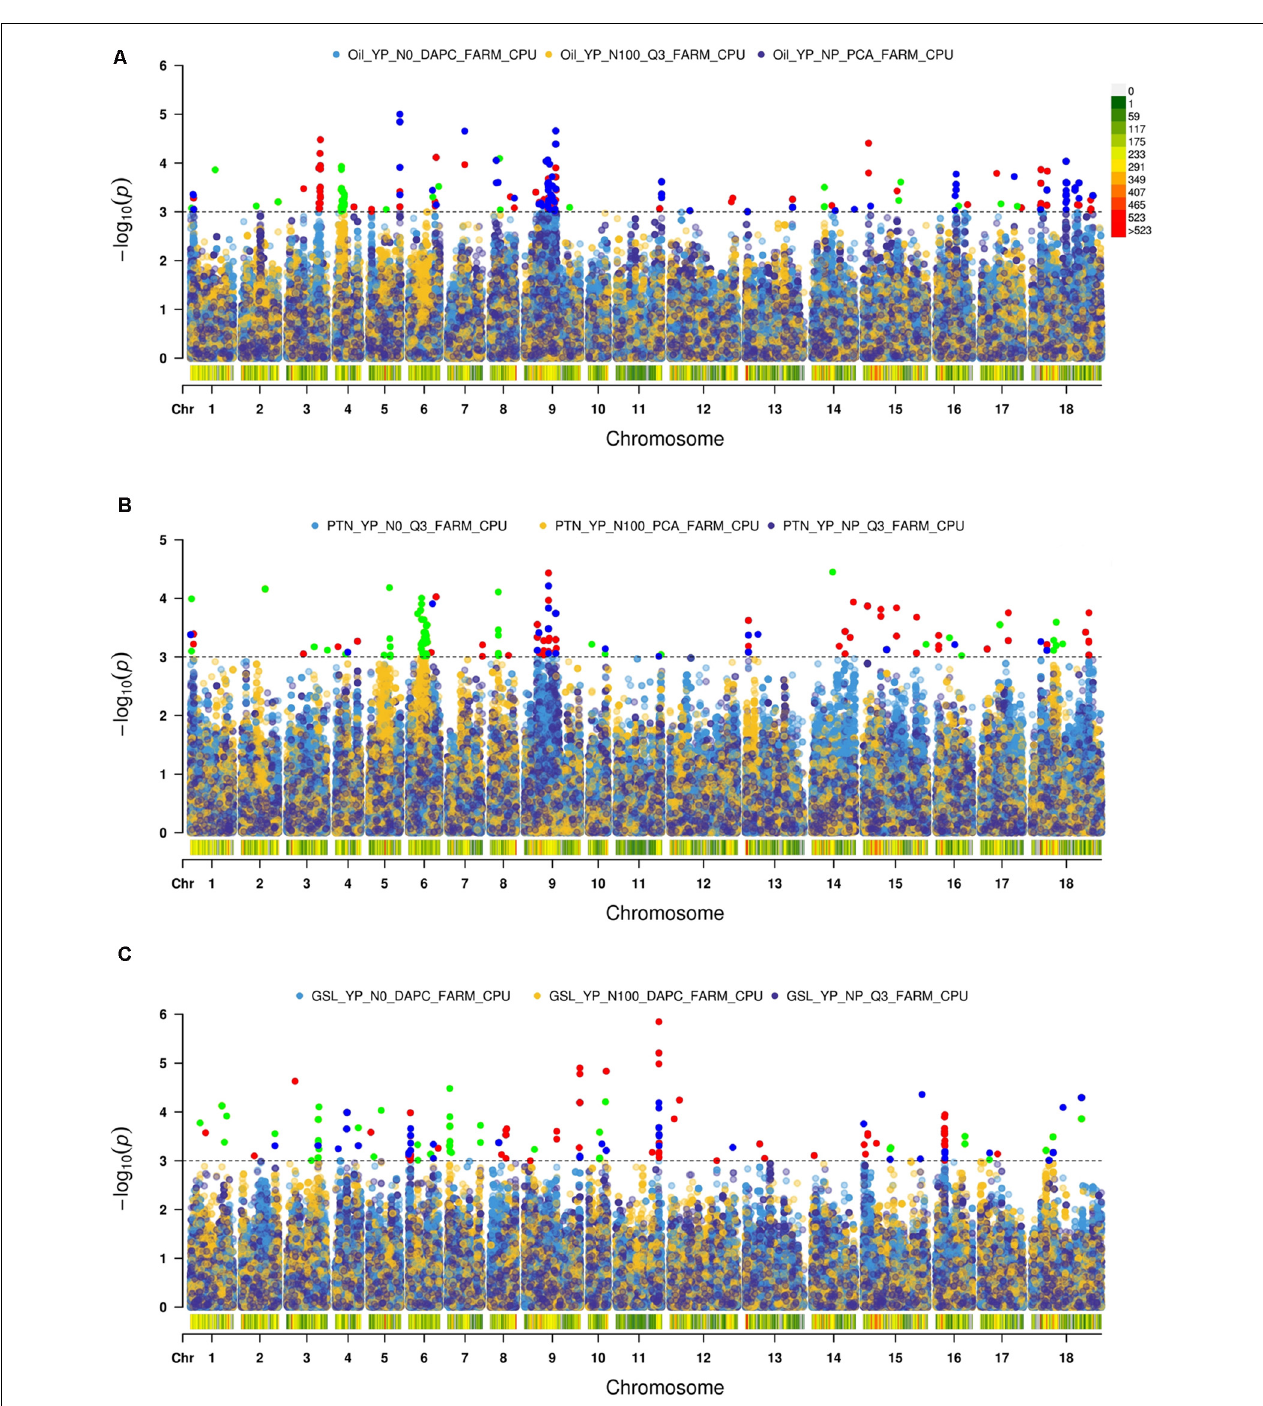
FIGURE 2 | Manhattan plots for Association Analysis of (A) oil, (B) protein, and (C) glucosinolates.